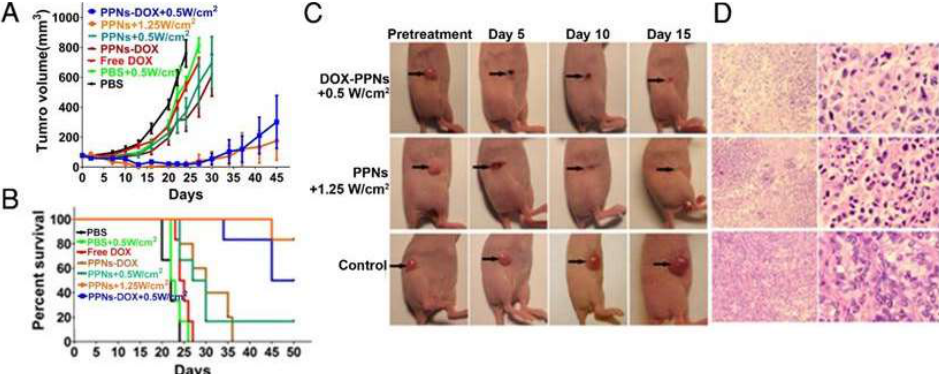
Figure 16. In vivo therapeutic response to PPNs-mediated chemotherapy combined with phototherapy. ( A ) In vivo antitumor efficacy after the intravenous treatment of various DOX formulations combined with PPNs-mediated phototherapy ( n = 6). The SKOV3 tumor-bearing mice were intravenously injected with PBS (control), free DOX (2.5 mg/kg), PPNs (2 mg/kg calculated on porphyrin), and PPNs–DOX (PPNs 2 mg/kg, DOX 2.5 mg/kg) on day 0, 5, 10, and 15, followed by various light irradiations for 2 min on tumors, 24 h post-injection. ( B ) Kaplan–Meier survival curves of SKOV3 tumor-bearing mice treated with the above indicated conditions, where tumor volume reached 500 mm 3 and was considered as the end point of survival data. ( C ) Photographs showing therapeutic response to PPNs-mediated phototherapy with irradiation at 0.5 W/cm 2 for 2 min and 1.25 W/cm 2 for 2 min, respectively. ( D ) H&E staining of tumor sections collected from control mice and PPNs-injected (2 mg/kg) and variously irradiated mice (0.5 W for 2 min and 1.25 W for 2 min, respectively), 24 h post-injection. Reproduced from Reference [54] ( Theranostics 07:3901 image No. 005, open access policy).